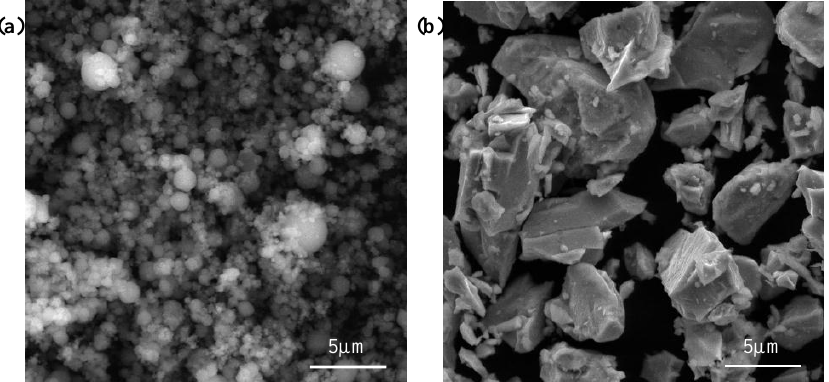
Figure 7. ( a ) Mg powder and ( b ) Mn powder.